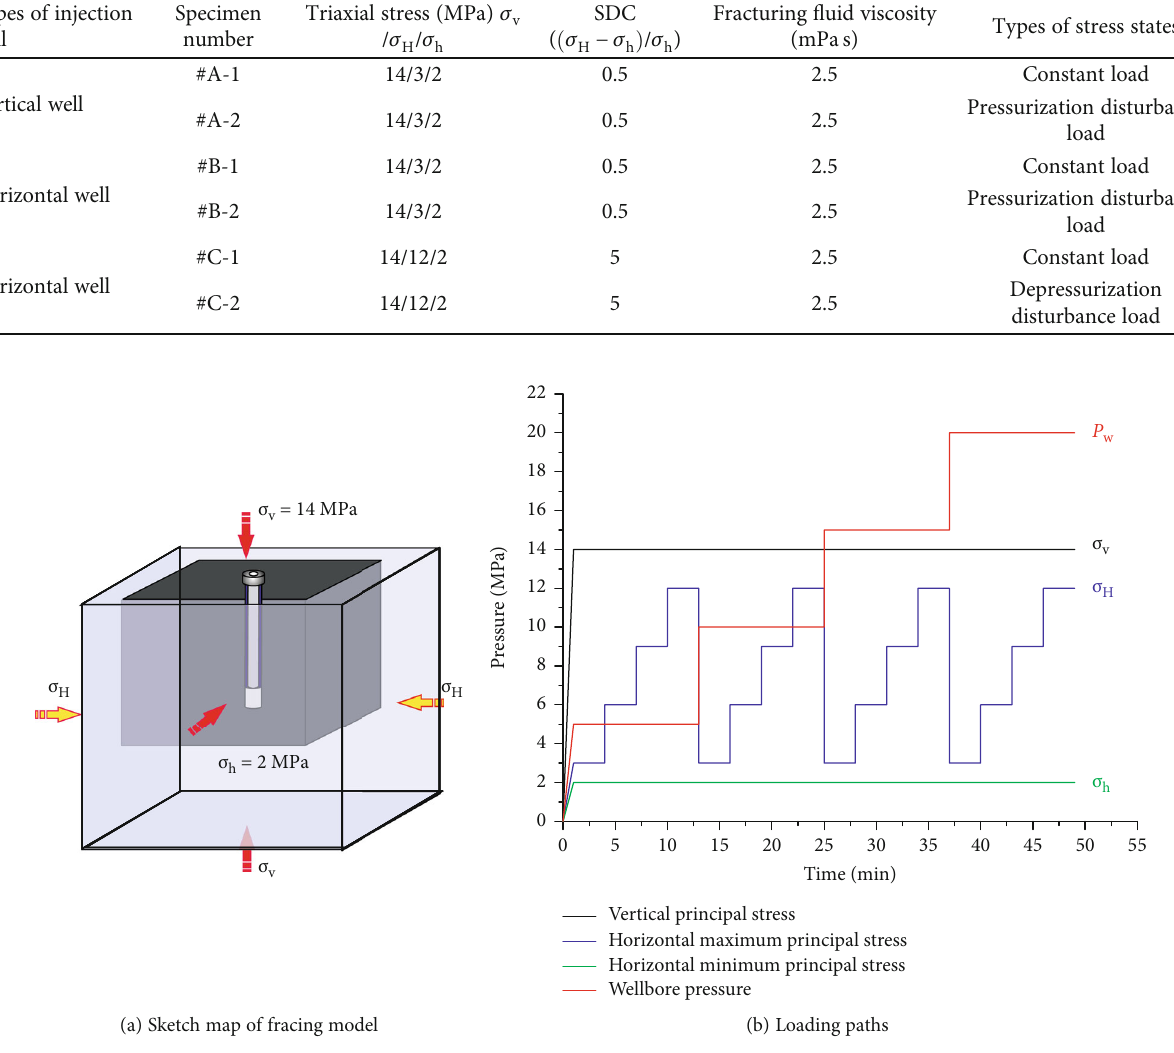
Figure 5: Scheme design for volumetric fracing true triaxial test with pressurization disturbance of vertical well (specimen